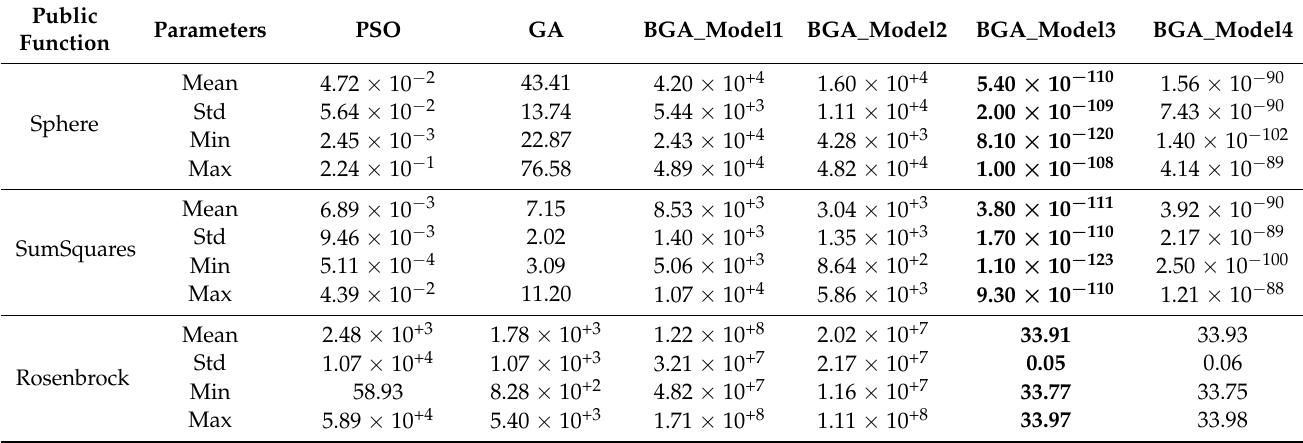
Figure 7. ( Top – Left ) Convergence of GA. PSO and BGA (third model) on sphere function during 400 steps. ( Top – Right ) Convergence of GA, PSO, and BGA (third model) on Ackley function during 400 steps. ( Down – Left ) Convergence of all of BGA models (four models (domains)) on sphere function during 400 steps. ( Down – Right ) Convergence of all BGA models (four models) on Ackley function during 400 steps. Table 4. Comparison of 35-dimensional results of GA and PSO and all of the models of the BGA.